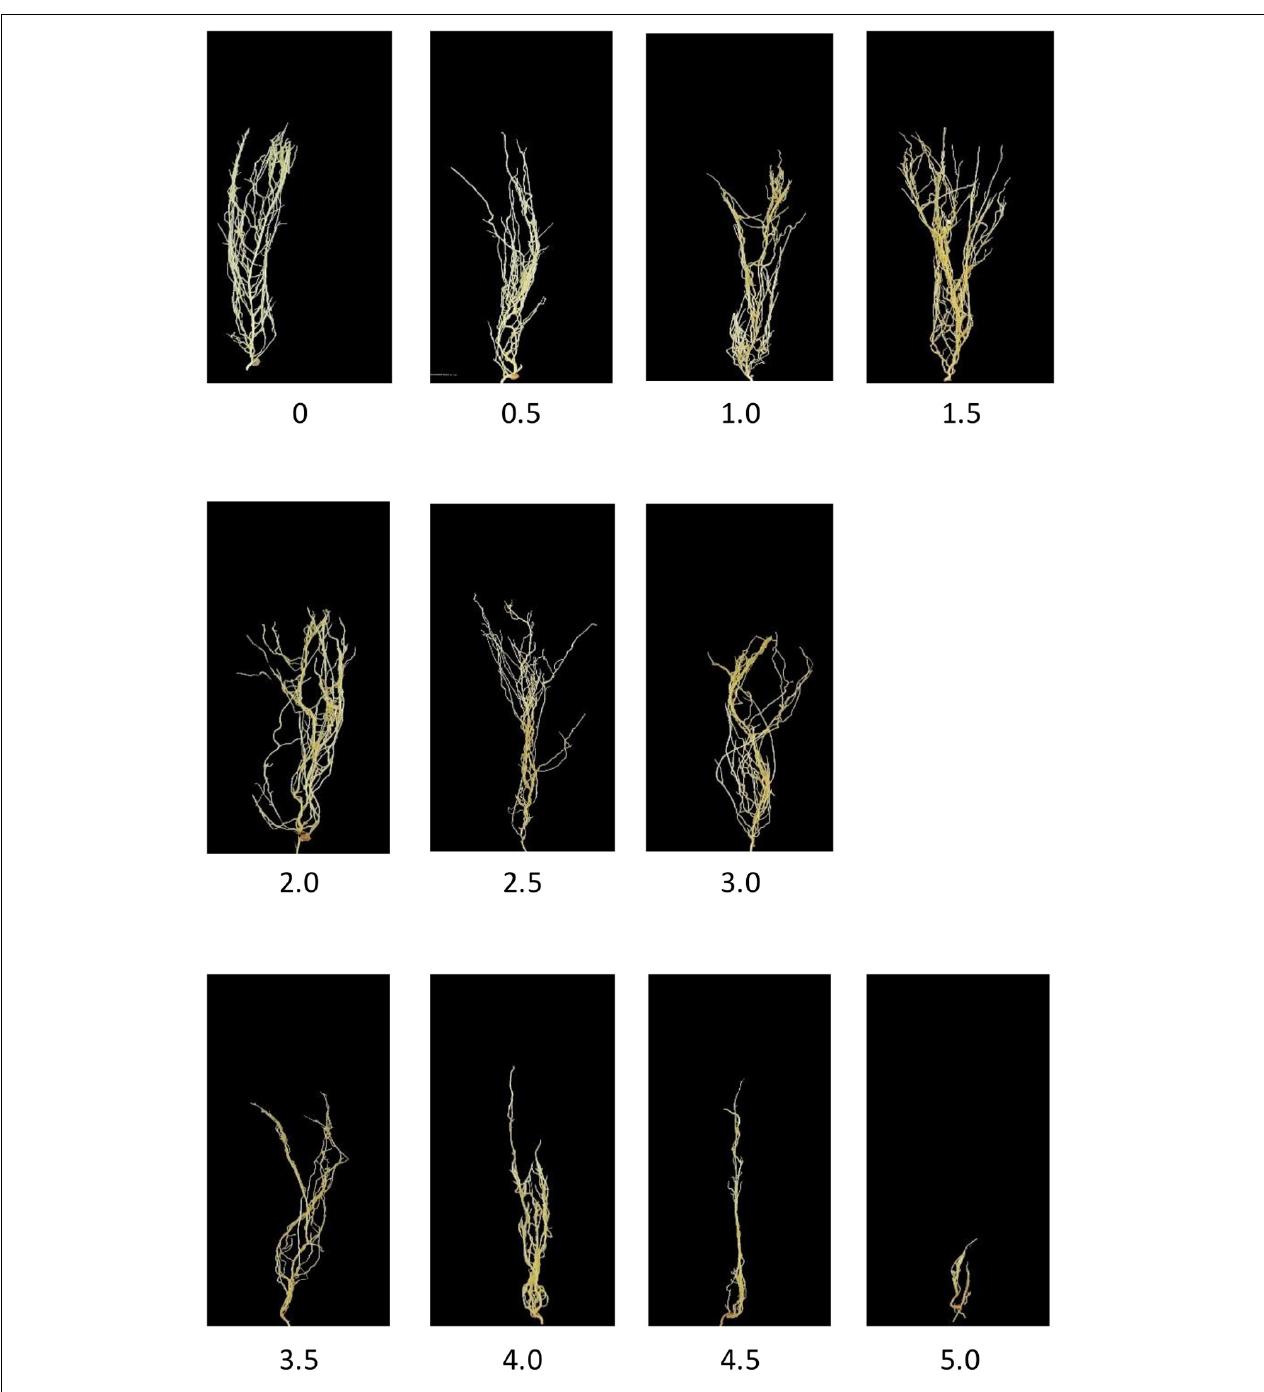
FIGURE 4 | Aphanomyces root rot disease severity